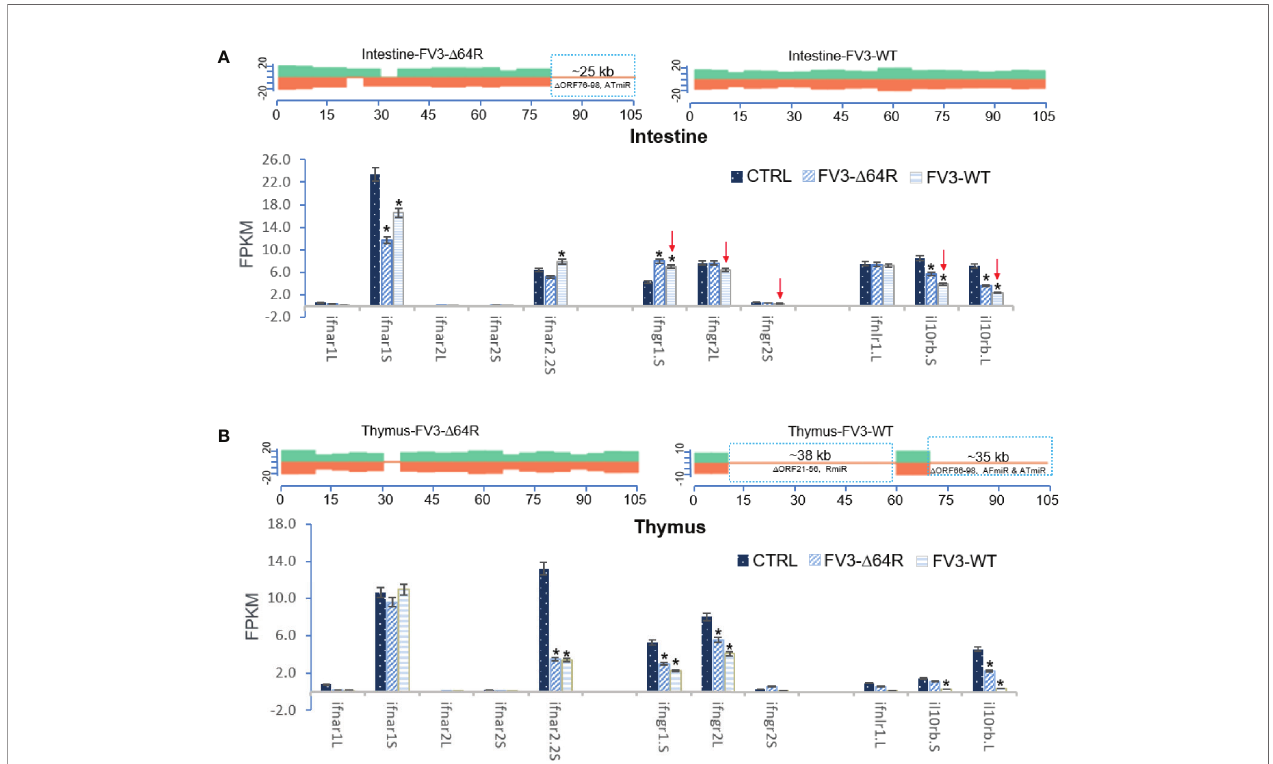
FIGURE 8 | Transcriptomic comparison of the viral genome and X. laevis mRNA encoding interferon receptor subunits in the mock, FV3- D 64R, and FV3-WT infected intestine (A) and thymus (B) . The distribution plots of mapped reads alone FV3 genome (GenBank Accession No. NC_005946.1) were shown as in Figure 3 . Partial coverages of the viral genome were determined forFV3- D 64R-infected intestine, and for both FV3-WT and FV3- D 64R in the infected thymus. Comparative alignments showed that transcripts of some ORFs and miRNA-enriched intergenic regions were defective (labeled and framed using blue line) as compared between two virus strains. Red arrows indicate further repression of some IFN-receptor genes corresponding to potential higher expression of respective miRNA by FV3-WT in the intestine. The putative miRNA-mediated repression of IFN receptor genes is not detected in FV3- D 64R infected thymus. Abbreviations and gene accession numbers are listed in Table 1 . *p (FDR) < 0.05 relative to the control, n = 5.